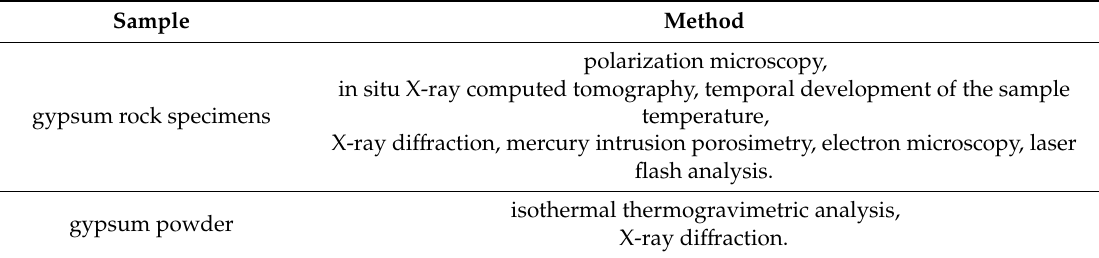
Table 1. Assignment of the methods to the respective samples in the exposure